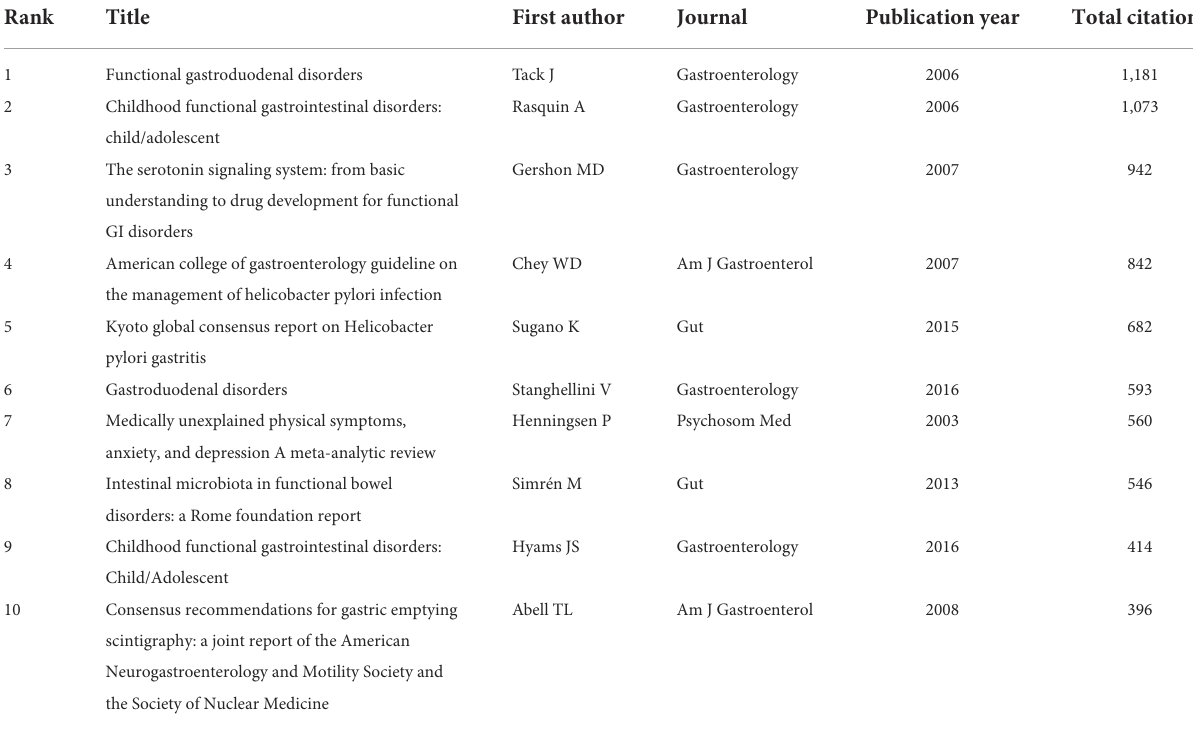
TABLE 5 Top 10 citation analysis of documents about